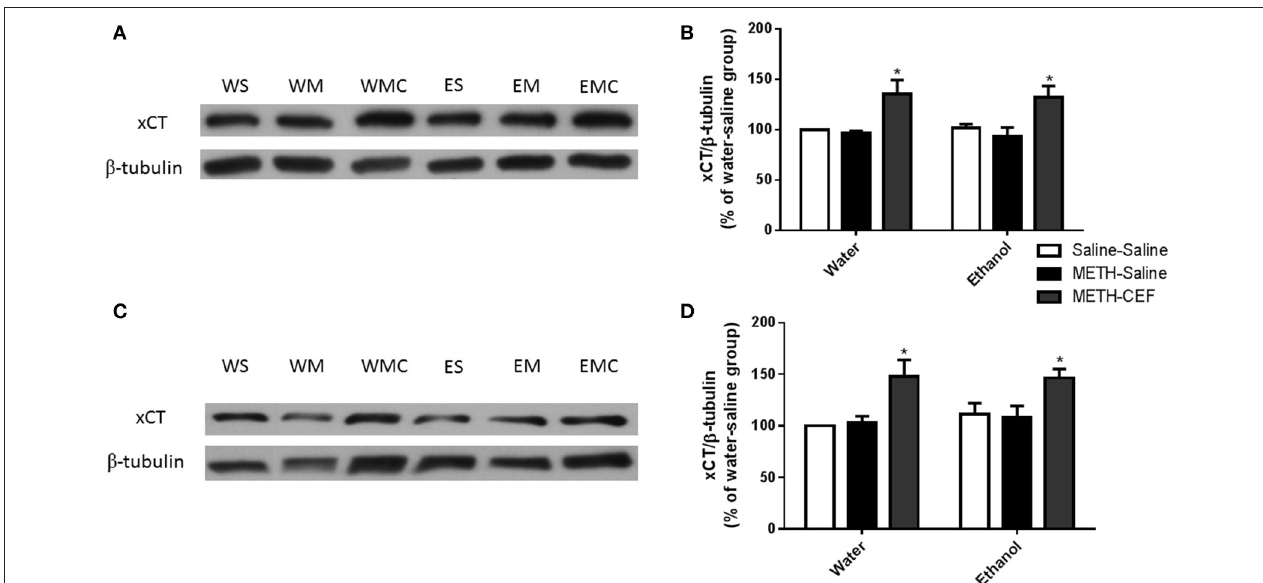
FIGURE 3 | Effects of METH (10mg/kg i.p. every 2h × 4), ethanol and CEF (200 mg/kg) on xCT expression in the NAc and PFC. (A,C) Immunoblots for xCT as well as β -tubulin, which was used as a control loading protein, in the NAc and PFC, respectively, as compared to water-pretreated groups and ethanol-pretreated groups. (B,D) Quantitative analysis revealed a significant increase in the ratio of xCT/ β -tubulin in METH-CEF-treated rats compared to the METH-Saline and Saline-Saline treated rats in the water and ethanol groups in the NAc and PFC, respectively. No significant change in xCT expression was revealed in the METH-Saline-treated groups compared to control in water- and ethanol-treated groups in either the NAc or PFC. * p < 0.05. Values shown as means ± S.E.M. n = 6 for each